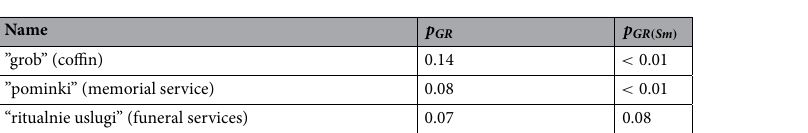
Table 3. The summary of p -values for standardized ( GR ) and smoothed standardized ( GR ( Sm )) data from Granger’s